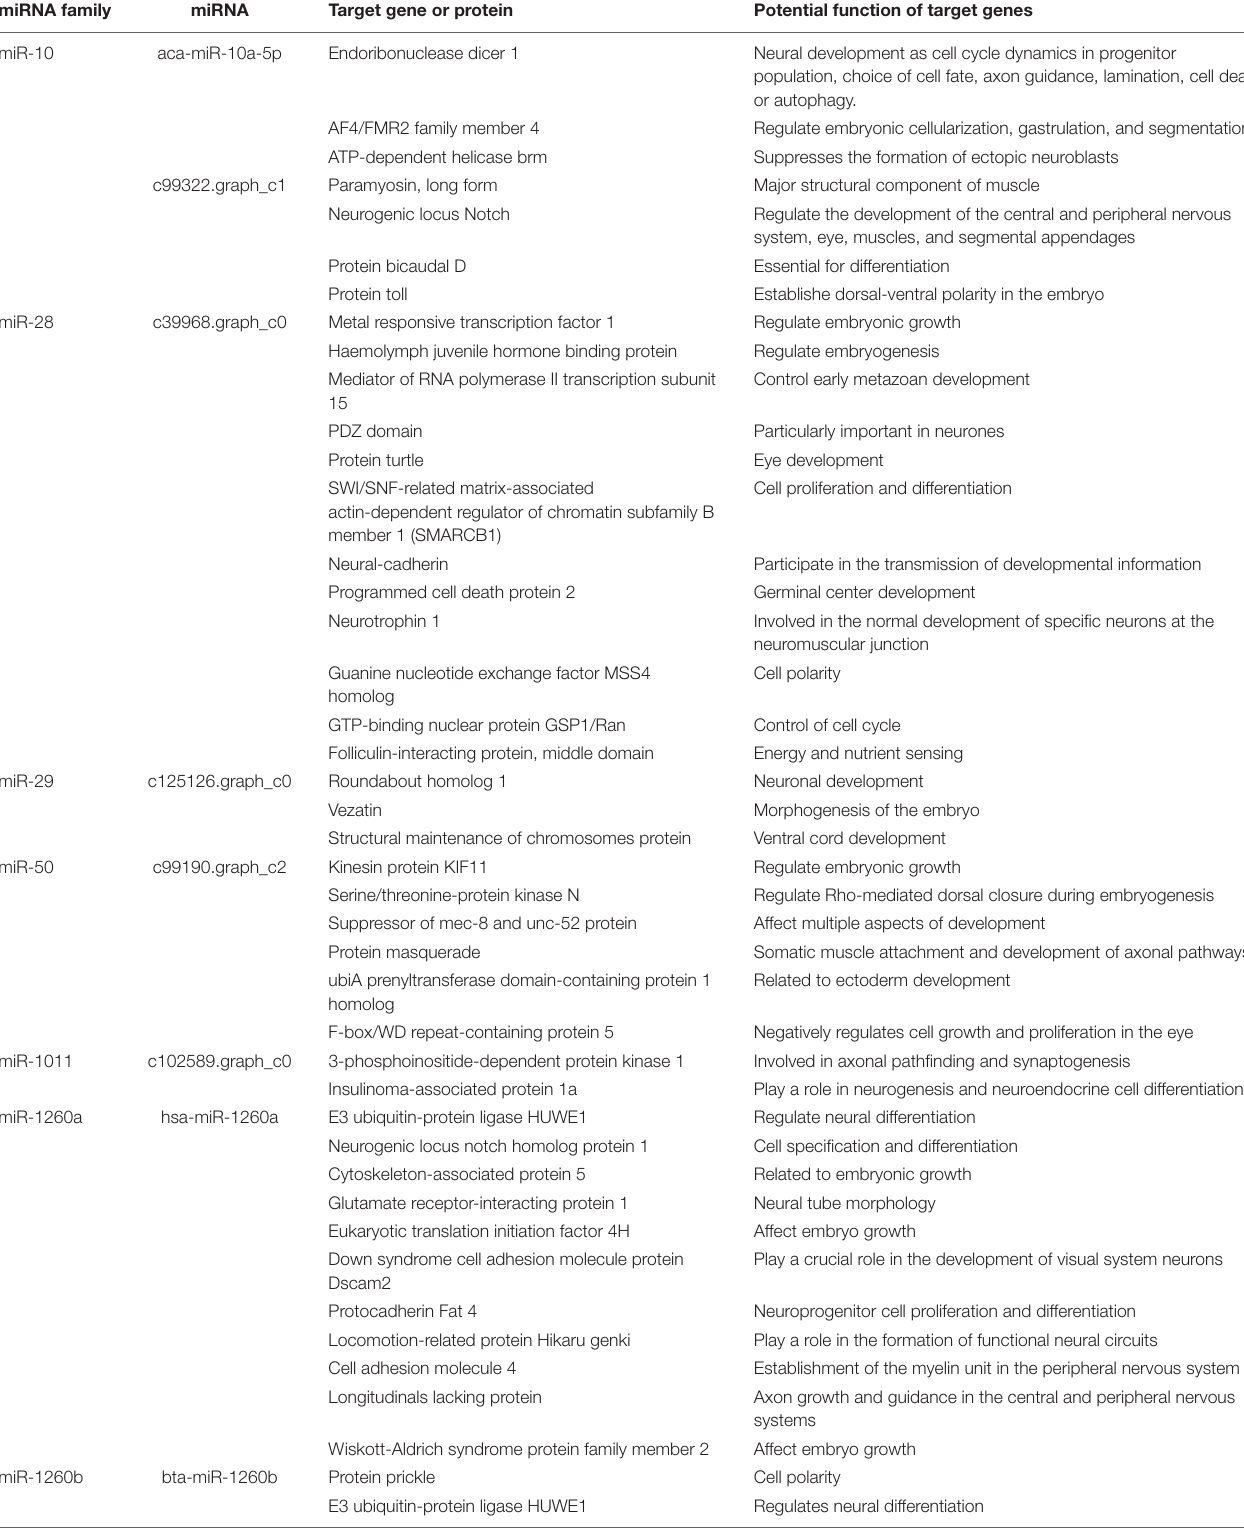
TABLE 3 | Potential miRNA target genes related to embryonic